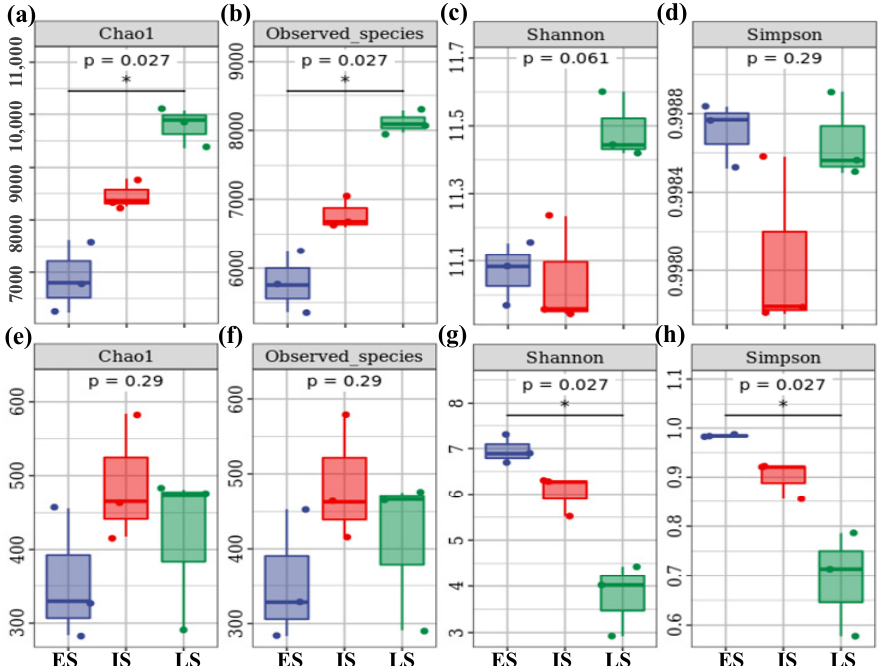
Figure 1. Changes in alpha-diversity of soil bacteria and fungi of broad-leaved Korean pine forest at